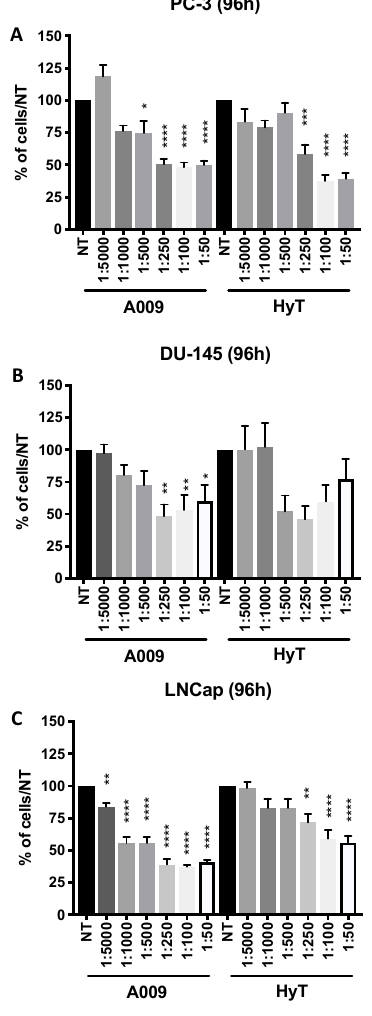
Figure 1. Effects of A009 on PC-3, DU-145, and LNCaP human prostate cancer cell proliferation. Graphs show the effects of A009 L4 and HyT, following 96 h of treatment on PC-3 ( A ), DU-145 ( B ), and LNCaP ( C ) PCa cell proliferation, as assessed by the MTT (3-(4,5-dimethylthiazol-2-yl)-2,5-diphenyltetrazolium bromide) assay. A009 L4 was more effective in inhibiting cell proliferation as compared with HyT, in a dilution-dependent manner. Not treated cells (NT) received complete RPMI medium. Results are shown as mean ± SEM.